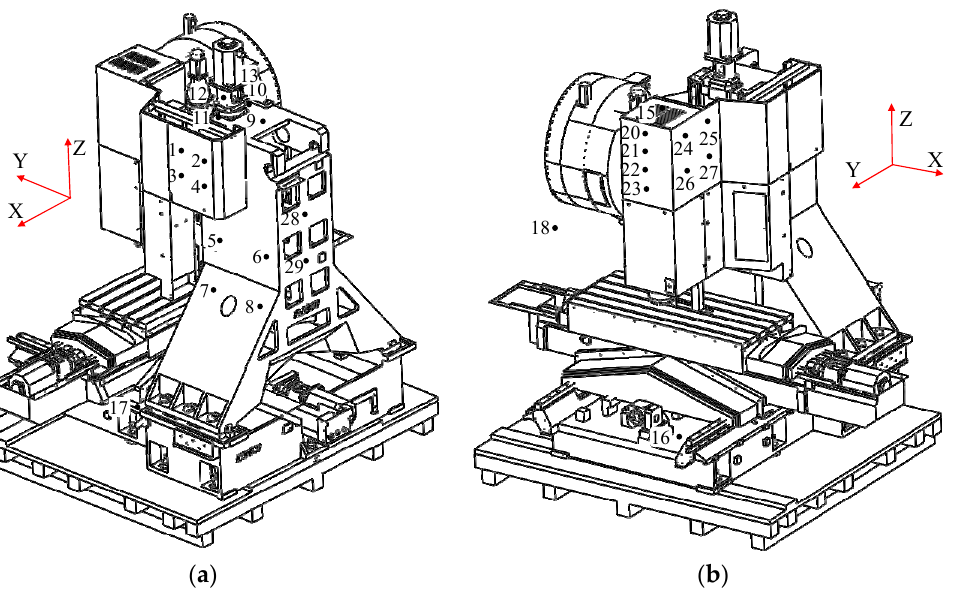
Figure 3. Location of thermal sensors on the machine tool. ( a ) a certain thermal symmetry structure design in the Y direction. ( b ) a certain thermal symmetry structure design in the Z direction.